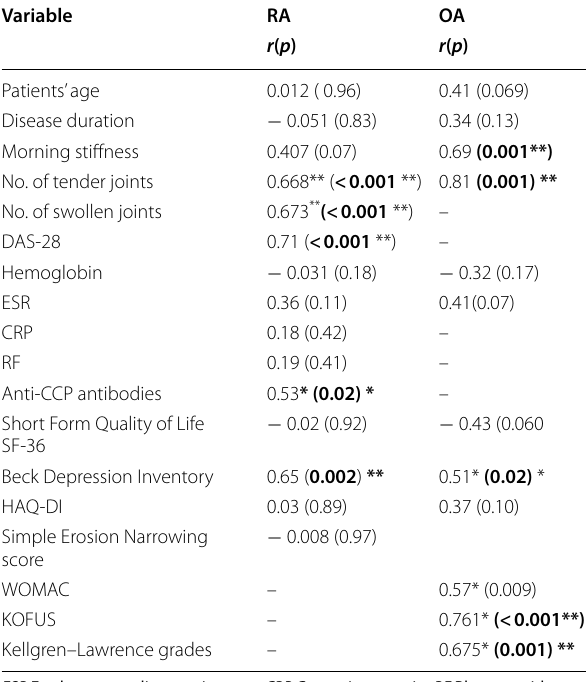
Table 4 Correlations of the Athens Insomnia scale with different variables of RA patients and OA patients